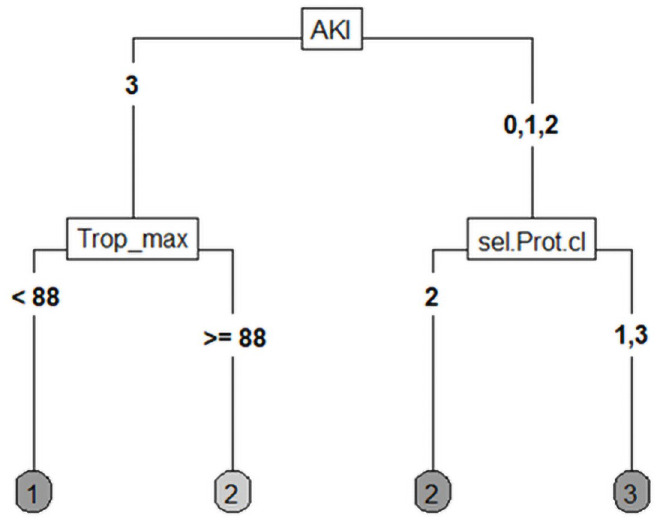
Fig 4. CART regarding outcome. Trop_max: Maximum value of troponin T in μ g/l, sel.Prot.cI: Selective proteinuria in mg/g creatinine (1: < 30 mg/gCrea, 2: 30–300 mg/gCrea, 3: > 300 mg/gCrea). Outcome 1: Death, 2: Remaining illness, 3: Recovering.